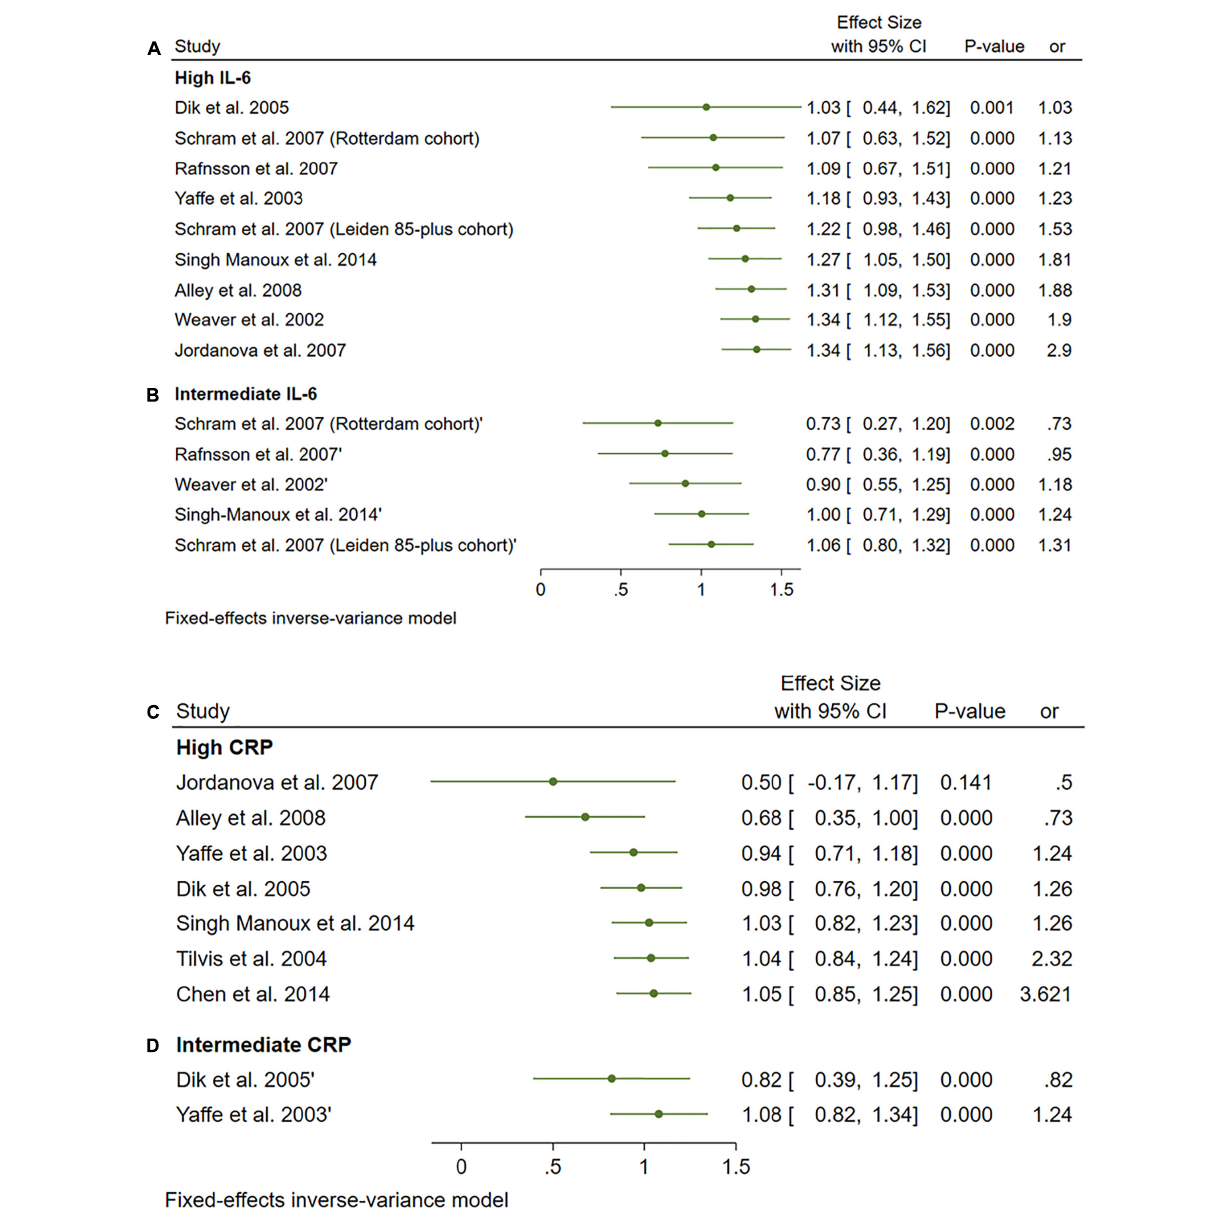
FIGURE11 (A) Forest plot of pooled odds ratio (OR) for interleukin-6 (IL-6) high concentration and cognitive decline. (B) Forest plot of pooled odds ratio (OR) for IL-6 intermediate concentration and cognitive decline. (C) Forest plot of pooled odds ratio (OR) for C-reactive protein (CRP) high concentration and cognitive decline. (D) Forest plot of pooled odds ratio (OR) for CRP intermediate concentration and cognitive